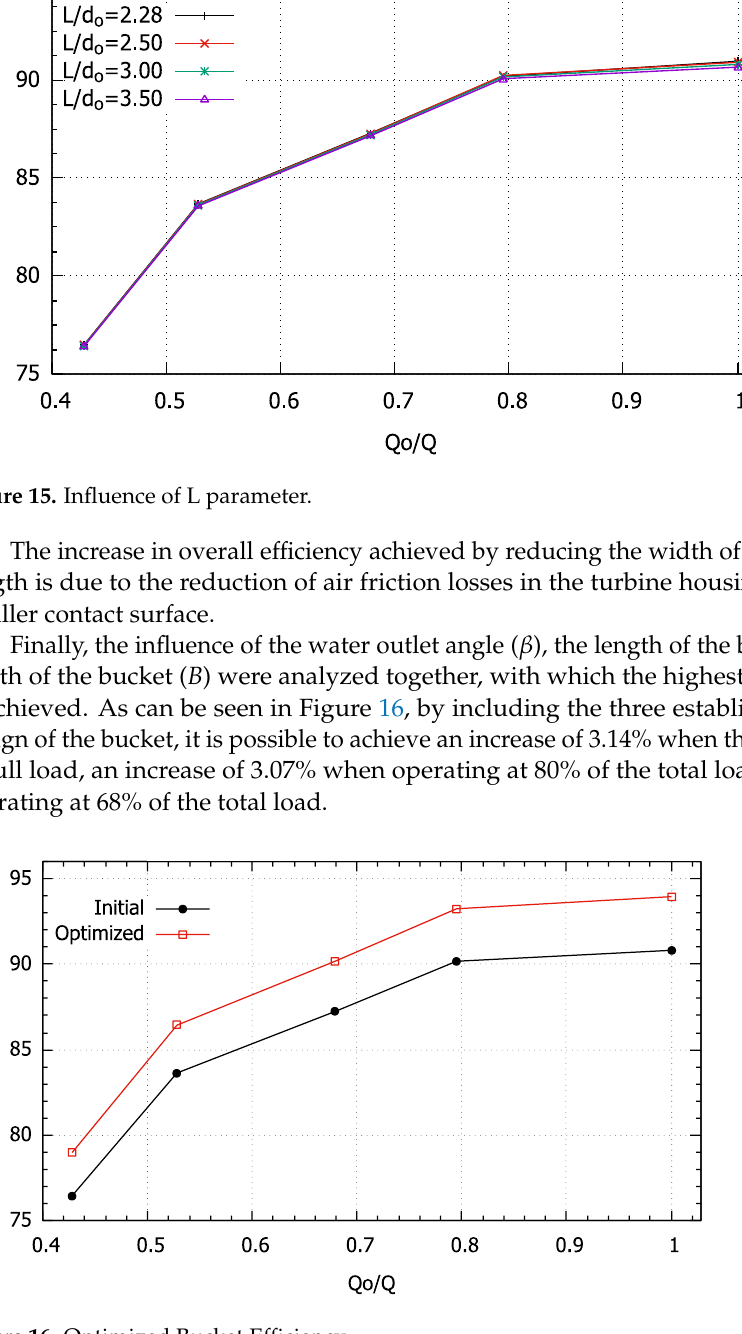
Figure 16. Optimized Bucket Efficiency.